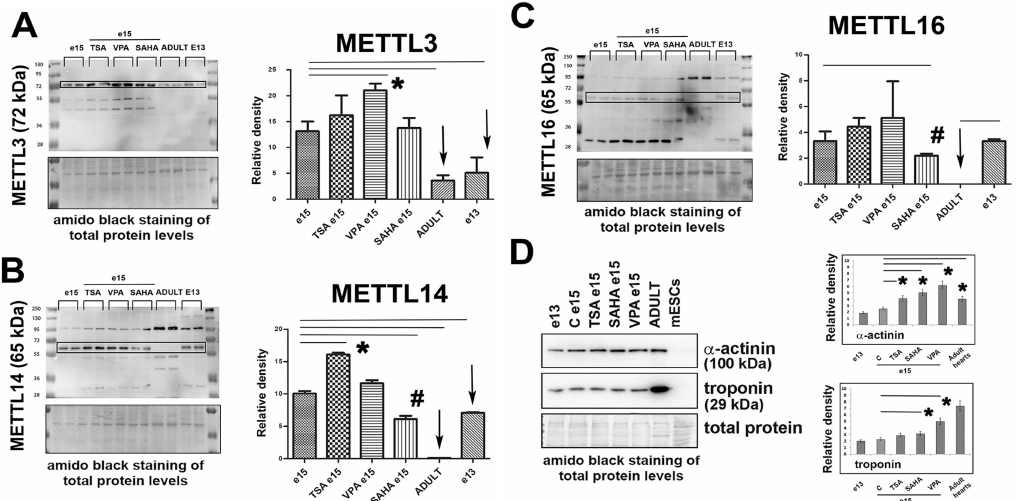
Figure 3. METTL3, METTL14, and METTL16 proteins studied in embryonic hearts treated with HDAC inhibitors. In non-treated, (Trichostatin A (TSA)-, valproic acid (VPA)-, and suberoylanilide